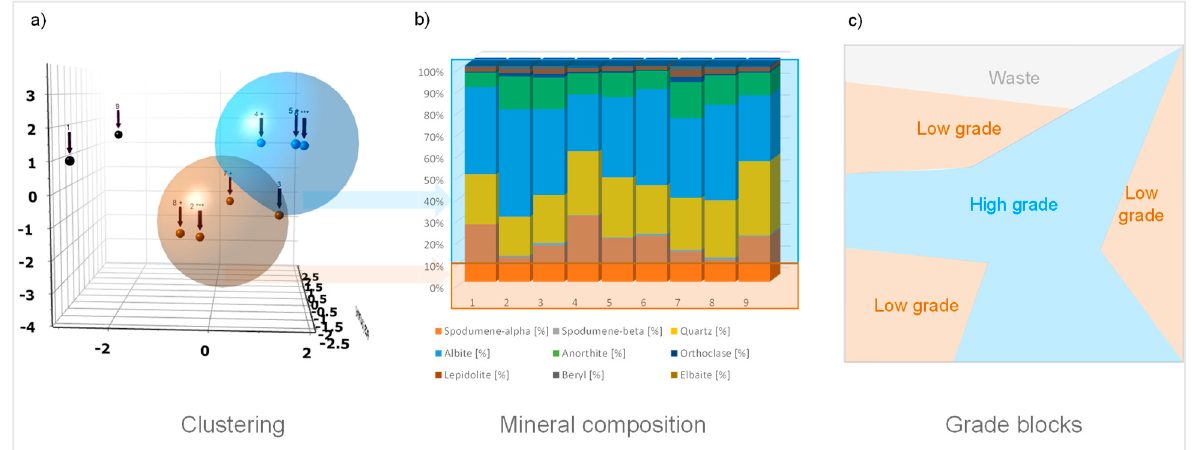
Figure 39. XRD cluster analysis ( a ), corresponding mineral quantities ( b ) and visualization of a theoretical grade block model ( c ) and mineralogical domains of a lithium hard rock deposit.